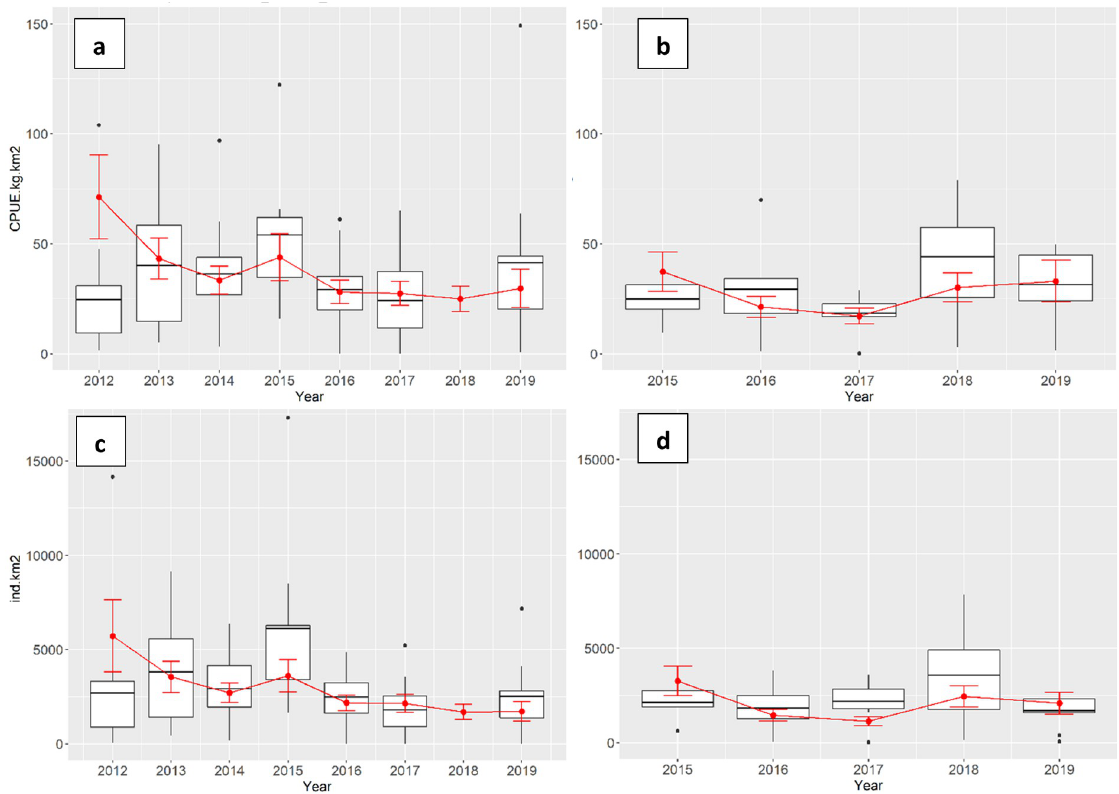
Fig 8. CPUE indices. Boxplots for the unstandardized time series over years represented with mean values (horizontal black lines), third and first quartiles (top and bottom vertical black lines, respectively) and outliers (black dots) plotted against the mean of predicted annual CPUE obtained for each cell of the grid (red dots) with standard errors (red lines). The spring time series is on the left ( a and c panels), the autumn time series is on the right ( b and d panels). Biomass index is represented in the upper panels ( a and b panels), while density index in the lower panels ( c and d